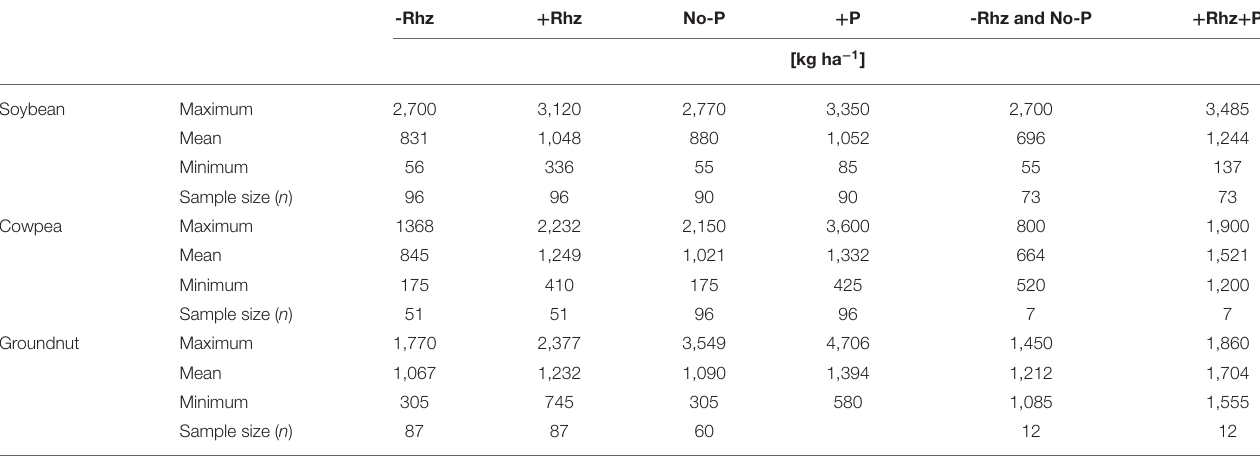
TABLE 1 | Grain yield (kg ha − 1 ) of uninoculated (-Rhz), no P application (no-P), -Rhz-no-P and the rhizobia (-Rhz) inoculated, P ( + P) application, and + Rhz + P combination in soybean, cowpea, and groundnut plants under field condition in